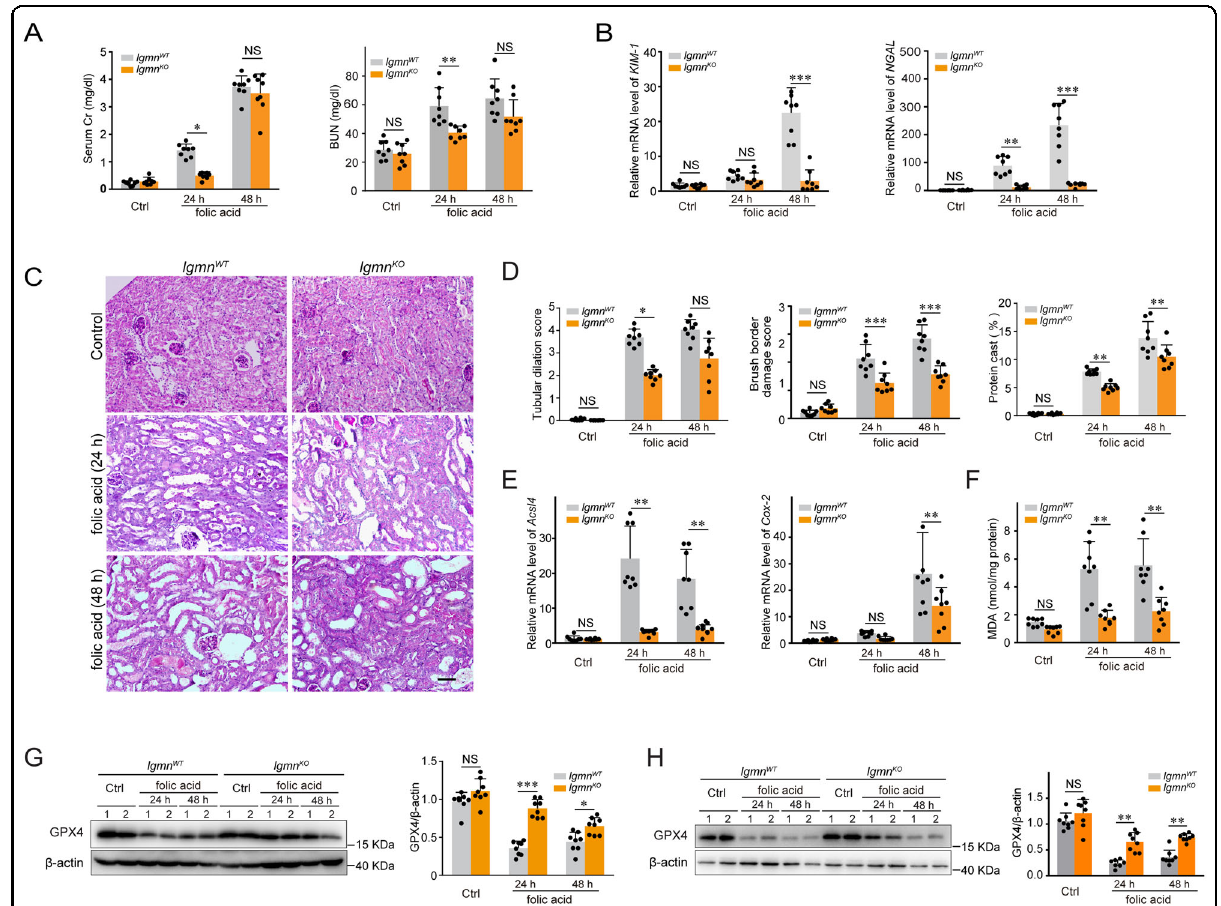
Fig. 6 Legumain de fi ciency attenuates tubular injury and ferroptosis in folic acid-induced AKI. Folic acid was administrated intraperitoneally to lgmn WT and lgmn KO mice, and samples were collected at 24 and 48 hours after injection (n = 8) A Renal functions assessed by serum creatinine and BUN levels. B Quanti fi cation of kidney KIM-1 and NGAL mRNA levels by qPCR. C Representative images of PAS-stained kidney sections. Scale bar, 50 μ m. D Quanti fi cation of histological renal damage. Tubular dilation and brush border damage are scored, and protein casts are presented as percentage areas. E Quanti fi cation of kidney Acsl4 and Cox-2 mRNA levels by qPCR. F Lipid peroxidation levels in kidneys were measured by MDA assay. G Protein levels of GPX4 in kidney samples assessed by western blotting. Right panel shows the statistical data. H Primary renal tubular epithelial cells were isolated from lgmn WT and lgmn KO mice after injection of folic acid and the protein level of GPX4 was quanti fi ed by western blotting. Left panels show representative images and the right panel shows the statistical data. All data are expressed as the mean ± SD. * P < 0.05, ** P < 0.01, *** P < 0.001; two-way